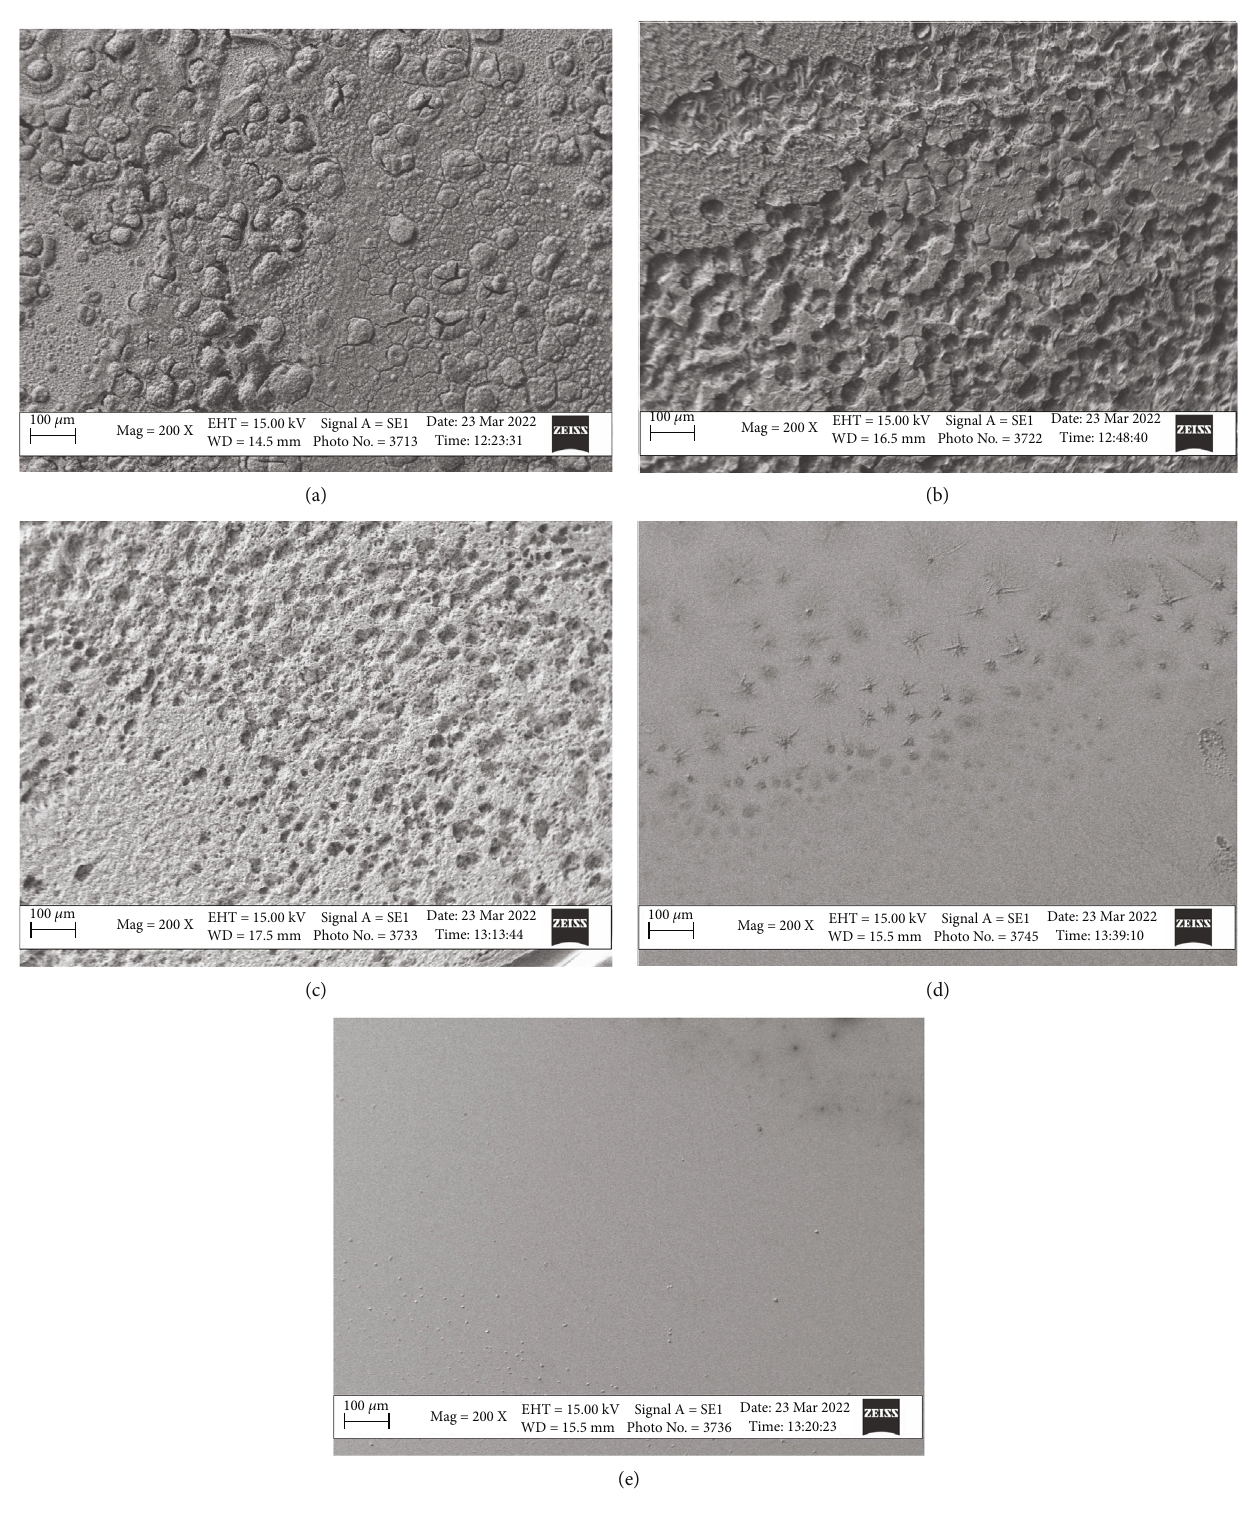
Figure 6: The surface of 09G2S steel samples after 24 hours of exposure to a 0.1% NaCl solution inhibited by sodium citrate with a concentration of (a) 0.5g/l, (b) 1.0g/l, (c) 1.5g/l, (d) 2.0g/l, and (e)